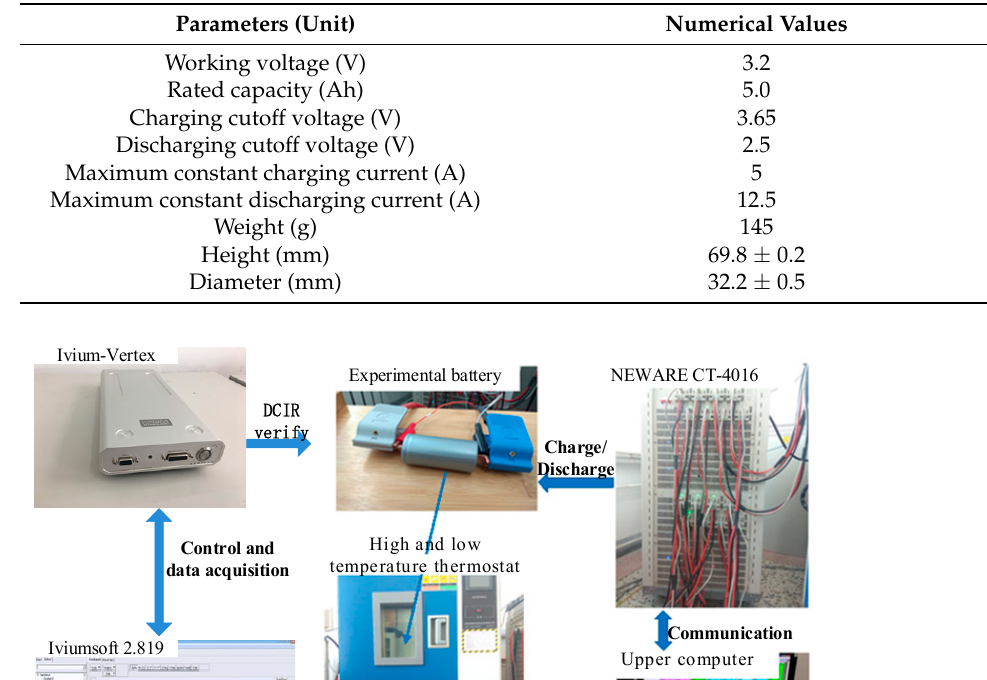
Table 2. Battery parameters in the experiment.